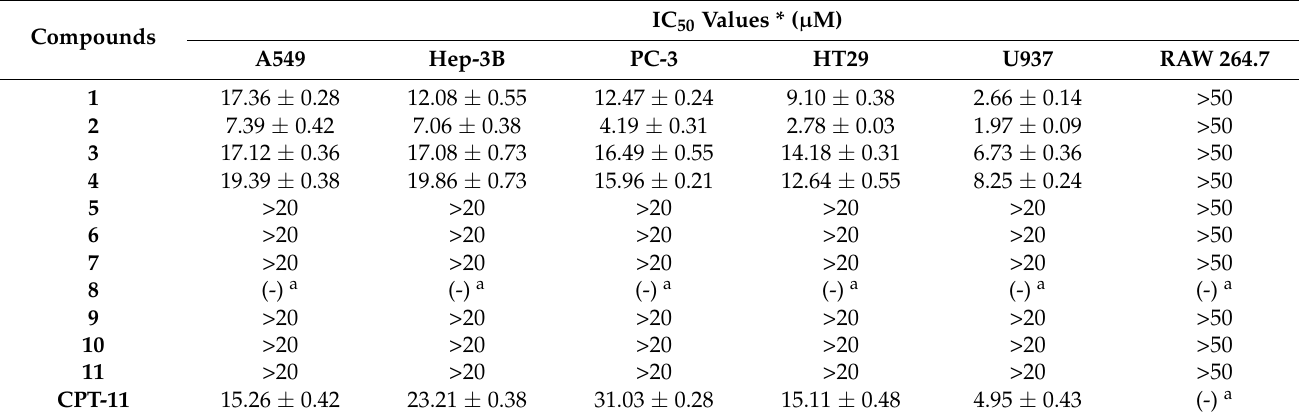
Table 3. Cytotoxic Activities of Compounds 1–11